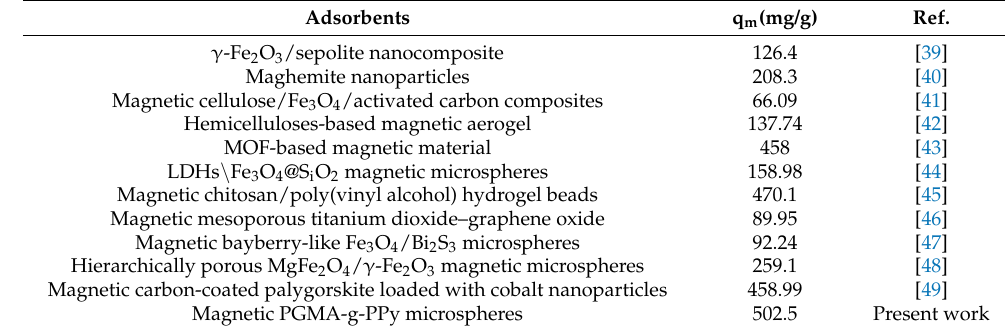
Table 2. Summary of the maximum adsorption capacities of CR onto various magnetic adsorbents.